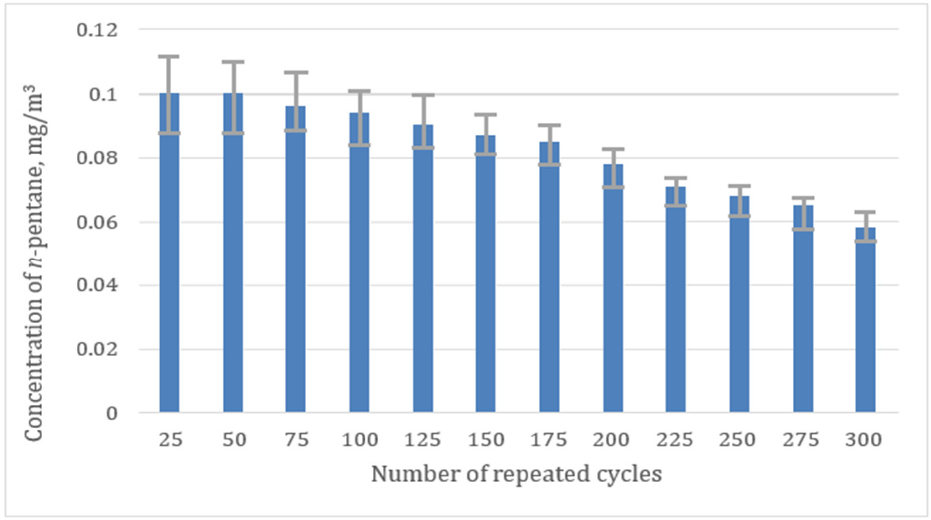
Figure 3. Graph showing the dependence of the n-pentane concentration on the number of cycles for the Al 2 O 3 sorbent.